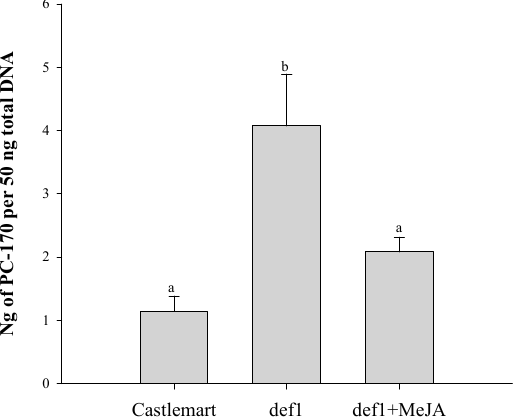
Figure 9. The colonization of PC-170 in the roots under the following different conditions: Castlemart: Castlemart tomatoes inoculated with PC-170; def1: def1 mutant tomatoes inoculated with PC-170; def1+MeJA: def1 mutant tomatoes inoculated with PC-170 and treated with the exogenous hormone MeJA. Each value is the mean ± SE ( n = 30). Different letters indicate statistical differences between treatments ( p < 0.05).